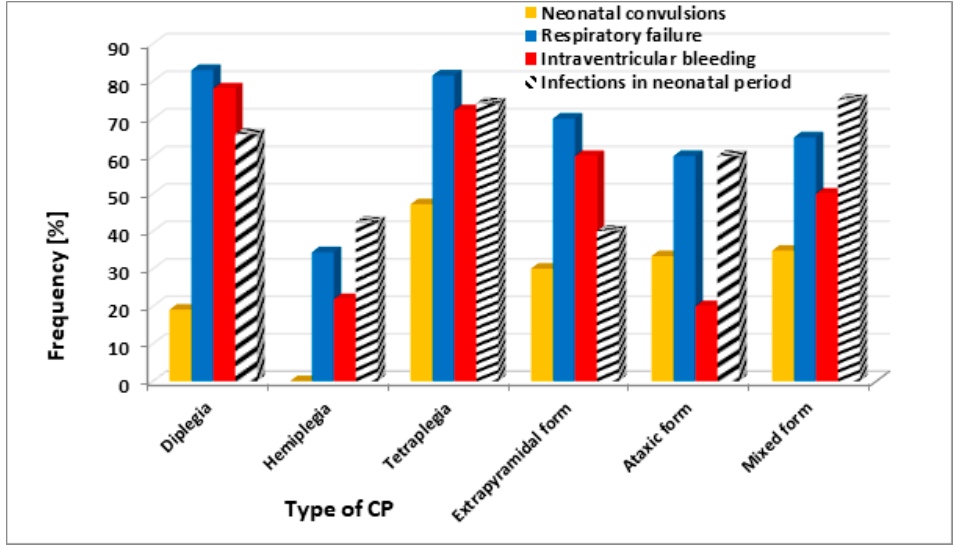
Figure 1. Frequency of neonatal convulsions, respiratory failure, intraventricular bleeding, and infections in neonatal period depending on the type of cerebral palsy.